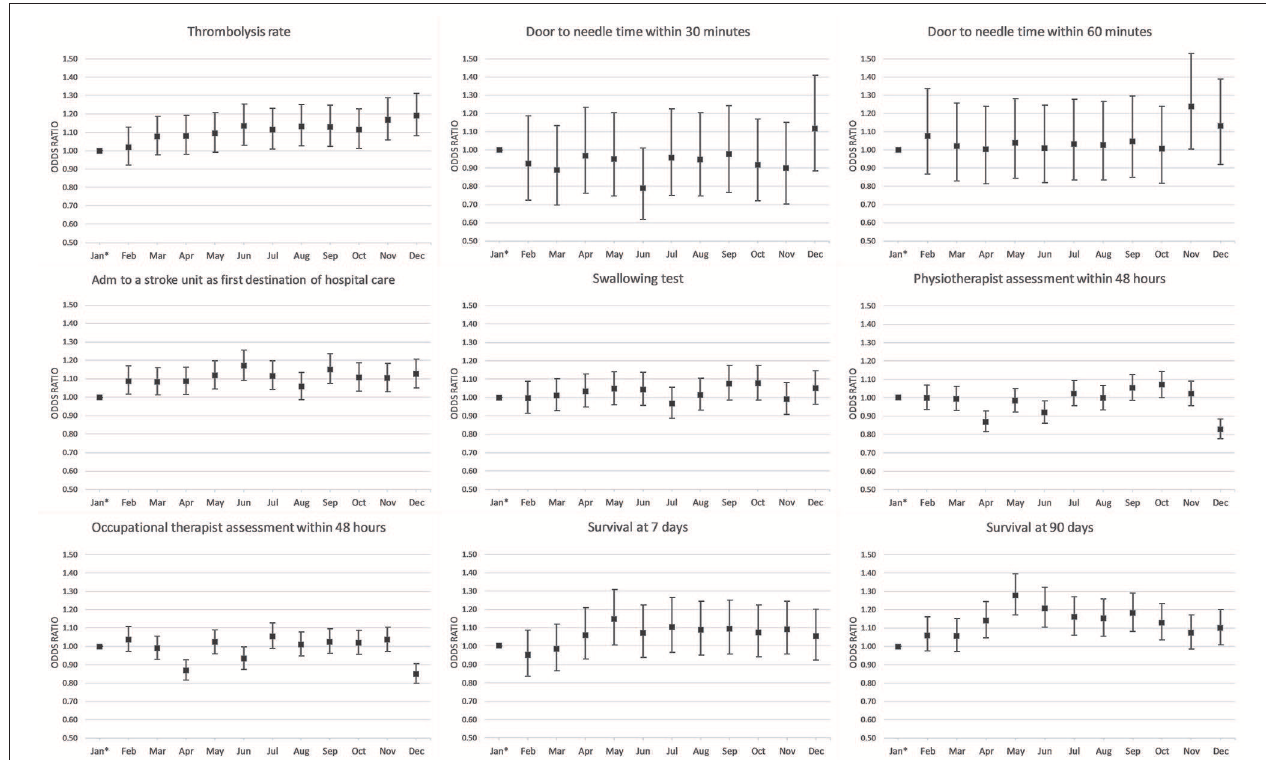
FIGURE 3 | Adjusted analyses of quality-of-care indicators and survival per month.